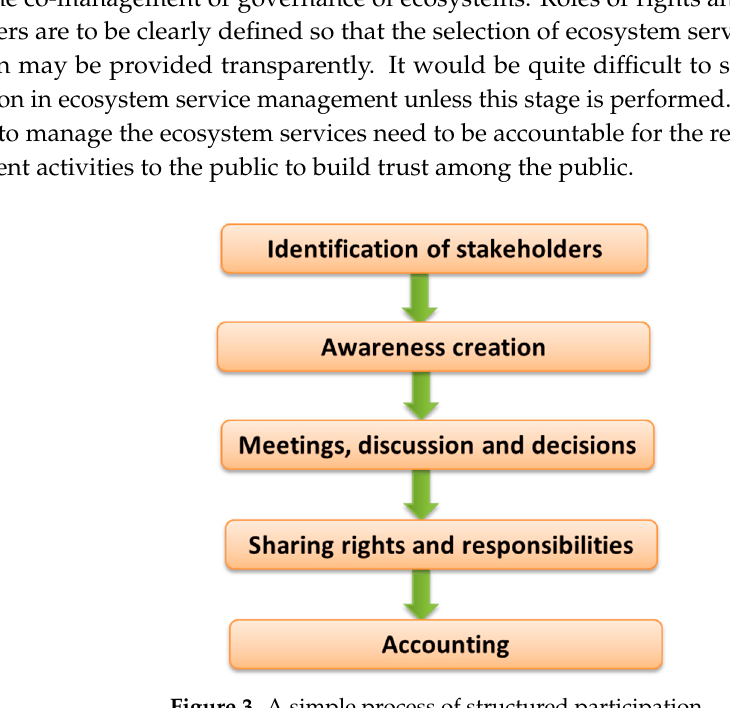
Figure 3. A simple process of structured participation.